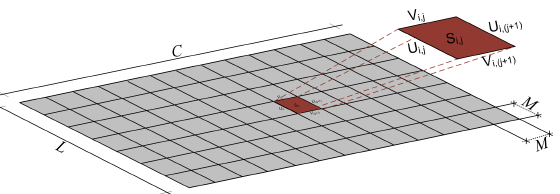
Figure 7. Regular discretization of total area for applying 3D